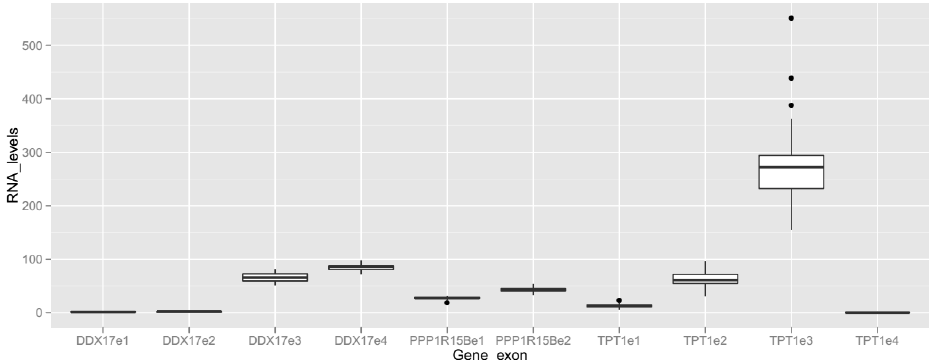
Figure 4. Box plot of RNA levels of multiple exons in selected genes across all blood samples subjected to an RNA-seq analysis. Selected exons (e1, e2, etc.) detected in the RNA-seq dataset are shown. See Table 2 for their Ensembl exon ID, mean , standard deviation ( SD ), and CV of the RNA levels. See legend of Figure 3 for the calculation of RNA levels, definition of the box, whiskers, and dots.